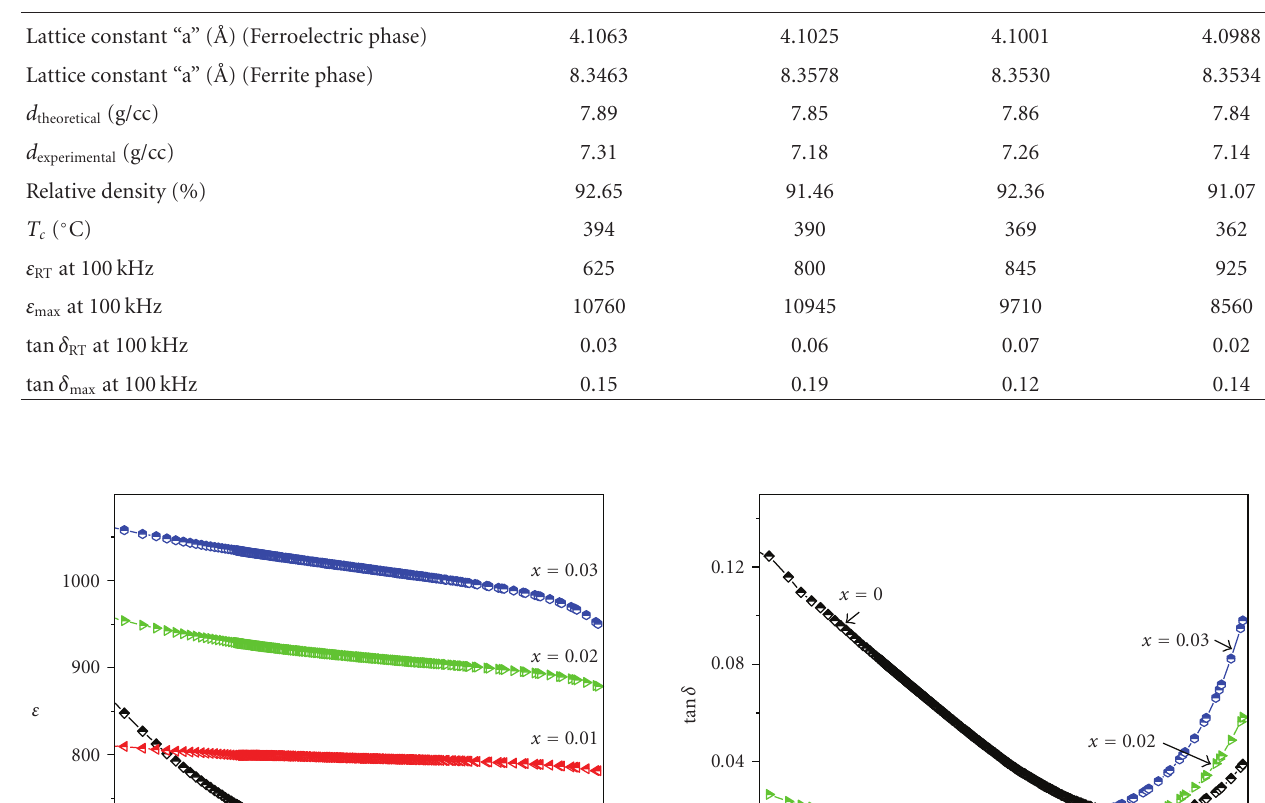
Table 1: Structural and dielectric parameters for 0.95 Pb 1 − 3 x/ 2 La x Zr 0 . 65 Ti 0 . 35 O 3 -0.05 Ni 0 . 8 Zn 0 . 2 Fe 2 O 4 composites. Parameters